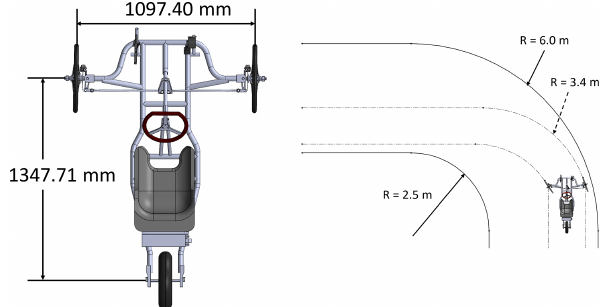
Figure 6. Schematic diagrams of the Ackermann steering geometry (positive Ackermann) and the wheel path.